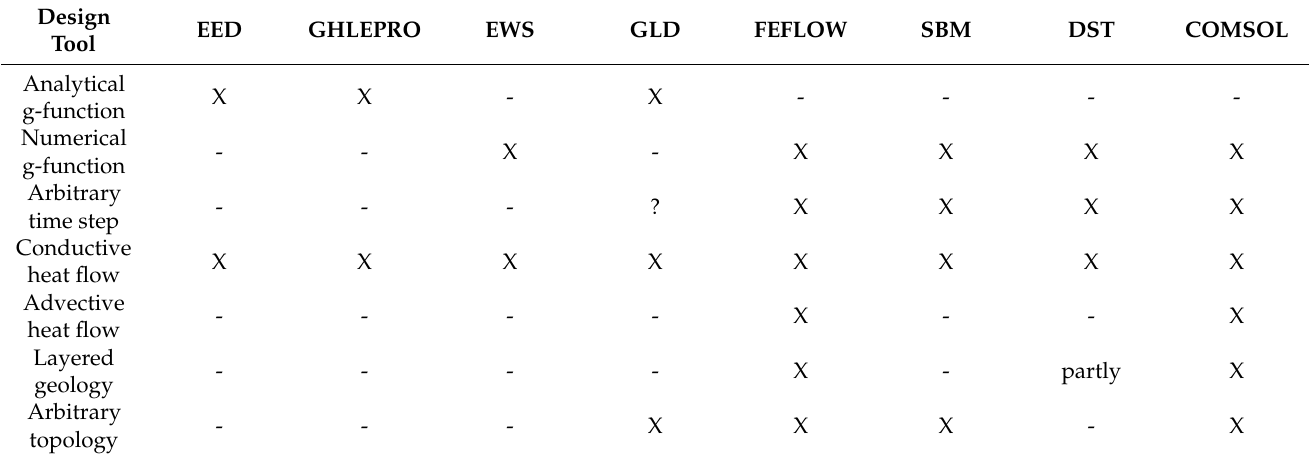
Table 2. Comparison of GHEX design tools (AIT,